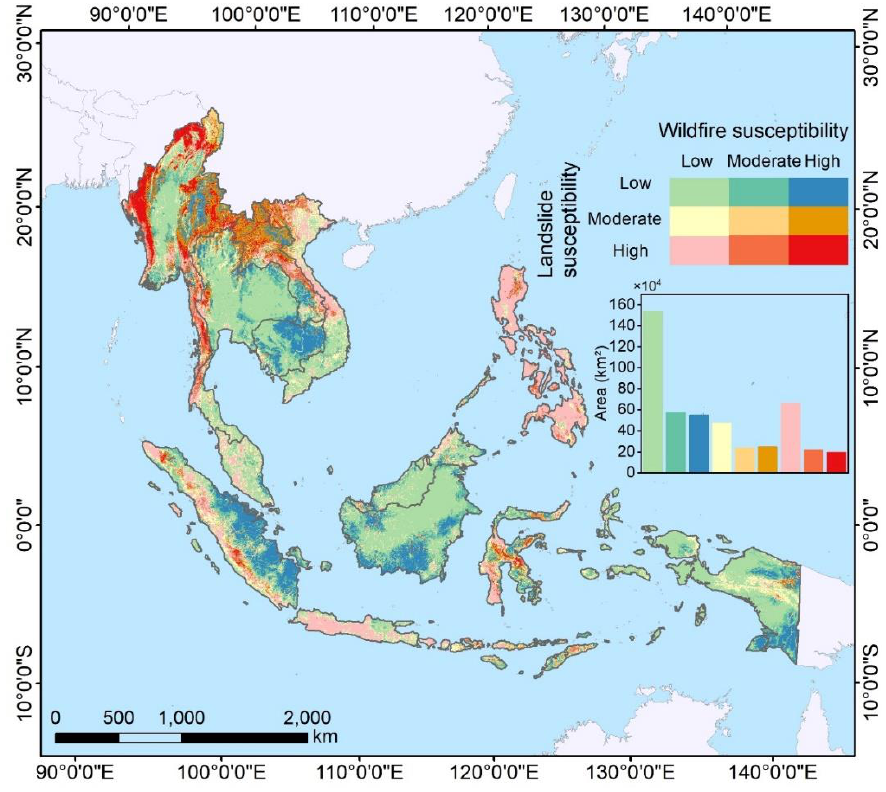
Figure 6. Overlaid landslide and wildfire susceptibility classification using the RF model for Southeast Asia.